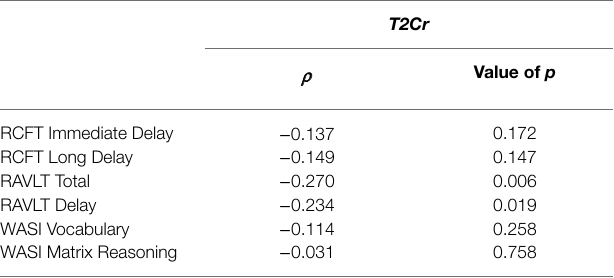
TABLE 5 | Bivariate correlation analysis (Spearman’s rho) between T2Cr and RCFT (immediate delay), RAVLT (total and delay), WASI Vocabulary and WASI Matrix